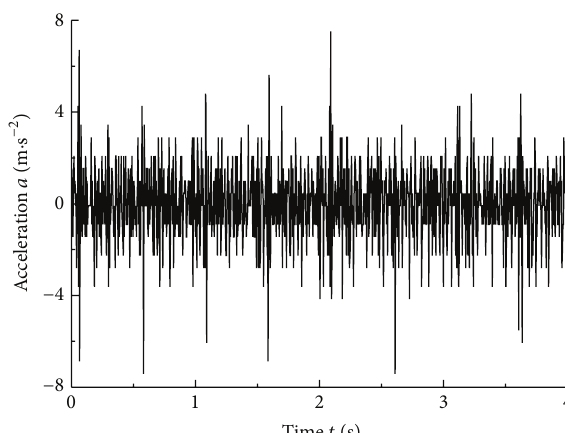
Figure 20: Vibration waveform of test rig experiment at the speed of 40